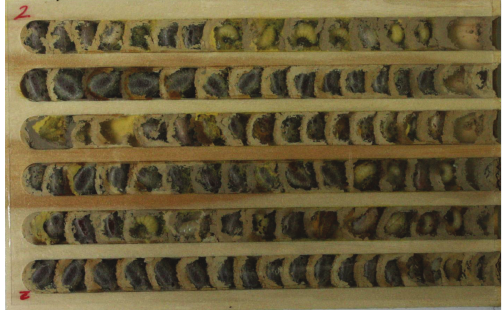
Figure 2: An example observation nest block with O. cornifrons cocoons. The nest block was designed for videotaping nesting behavior of O. cornifrons by covering the top of the block with transparent plastic